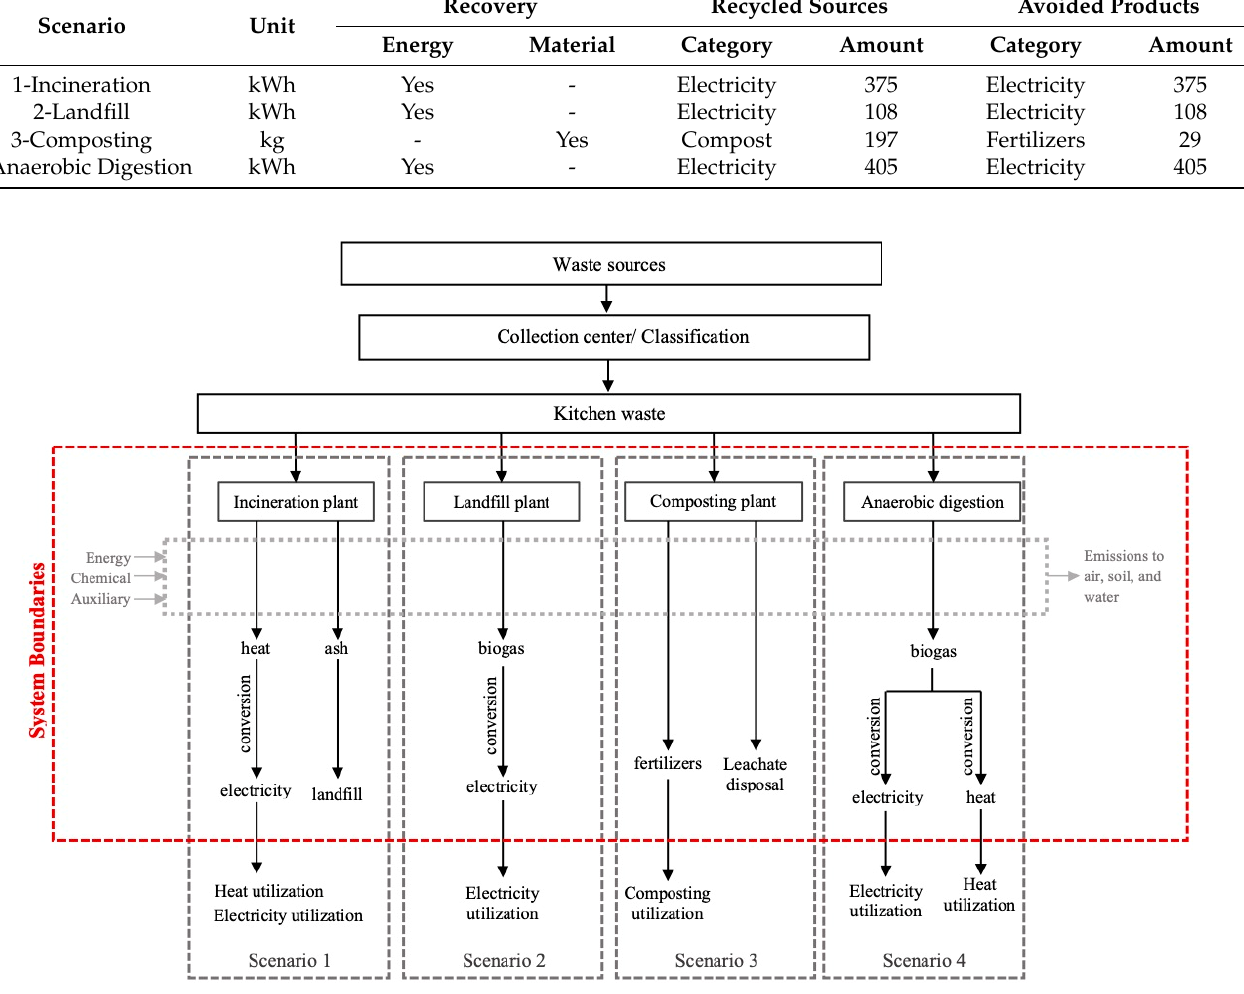
Table 2. Main input and output data at 1 metric ton kitchen waste treated.